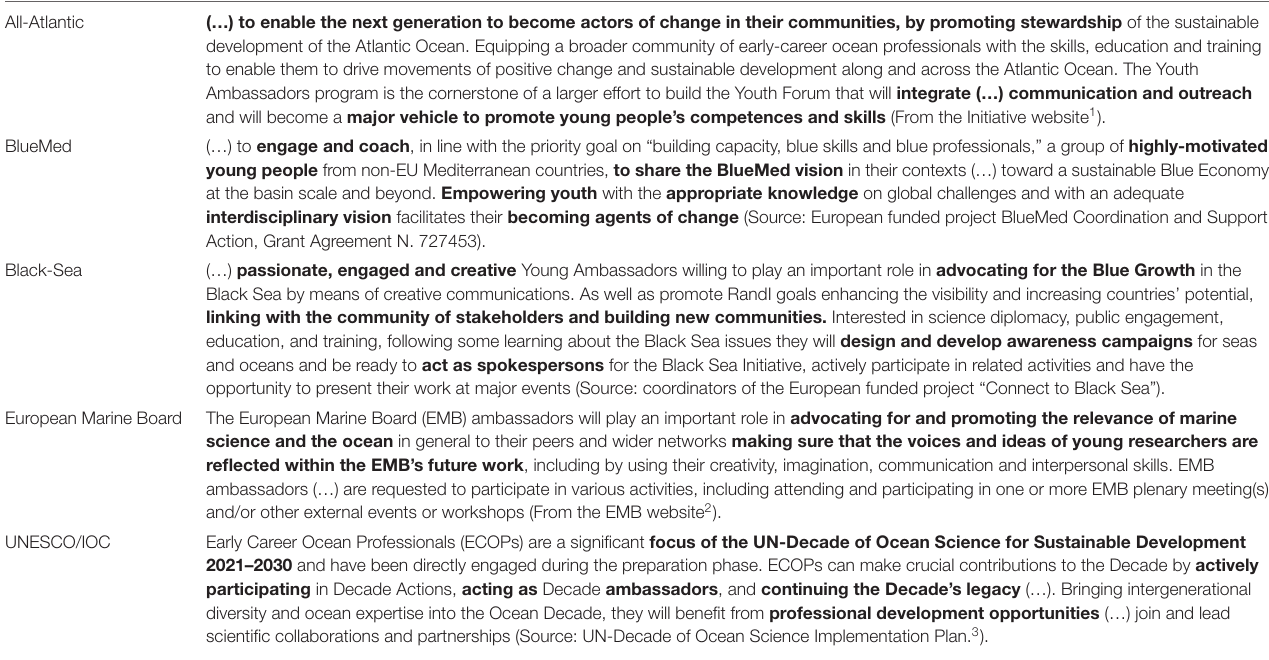
TABLE 2 | Description of the ambassadors’ programs published on the websites of home institutions or in official documents (in a single case in which a description was not publicly available, the authors report the exchanges with the Program coordinator).